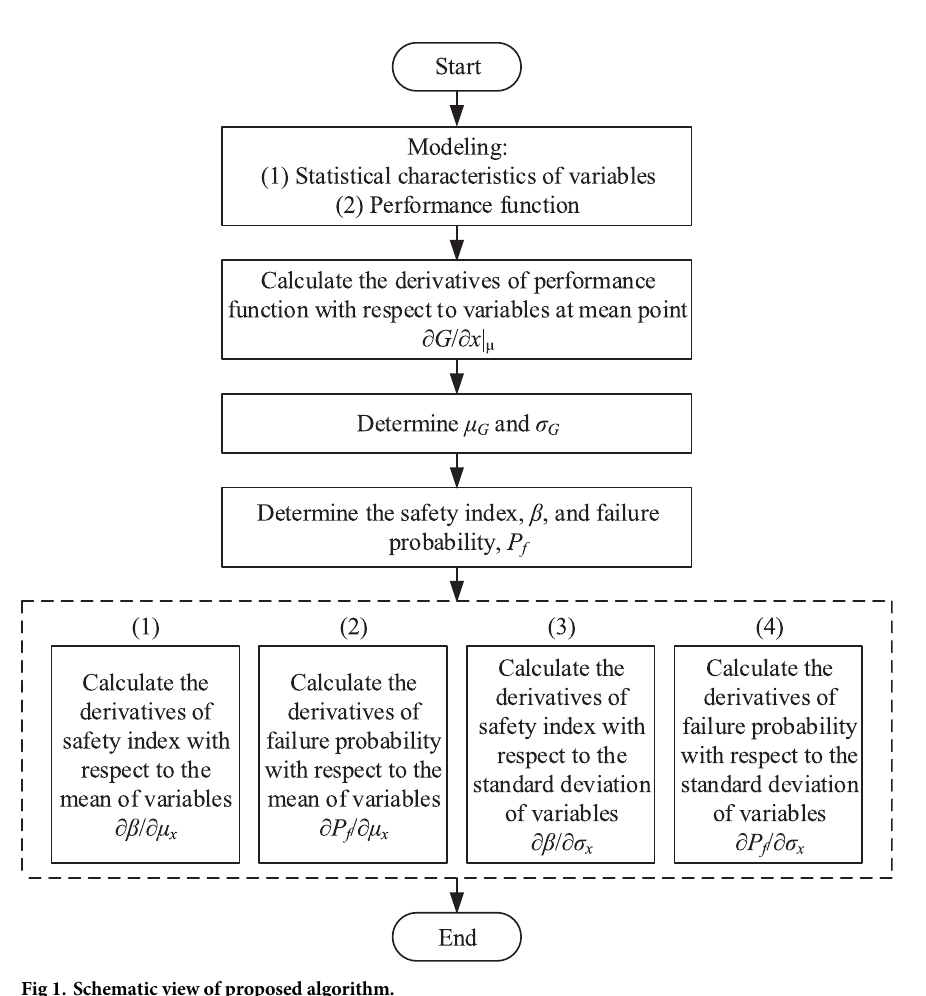
Fig 1. Schematic view of proposed